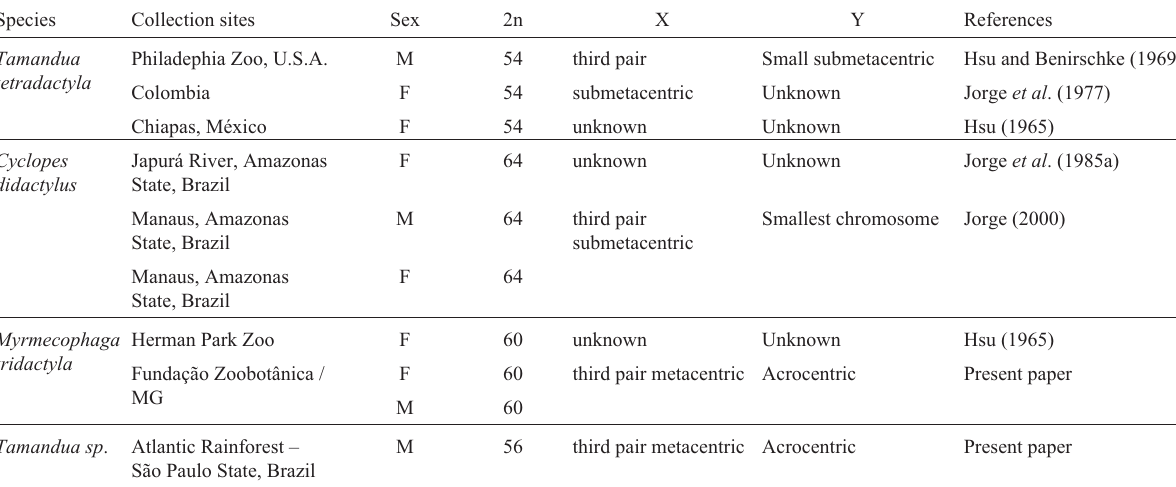
Table 2 - Karyotypes of anteater species, according to Wetzel (1985) and Nowak (1999).